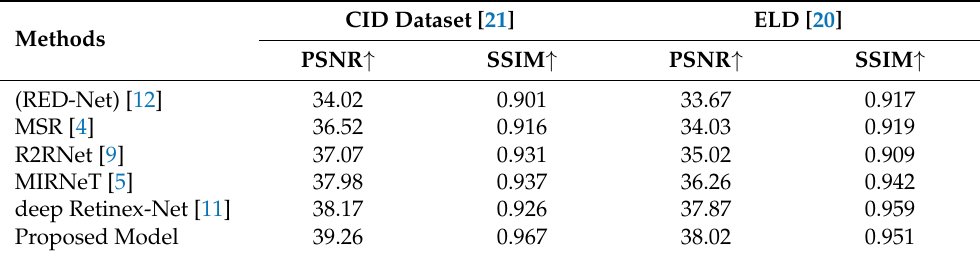
Table 4. Comparison of image denoising in the CID data set [21] and ELD [20] with respect to our model and existing methods.